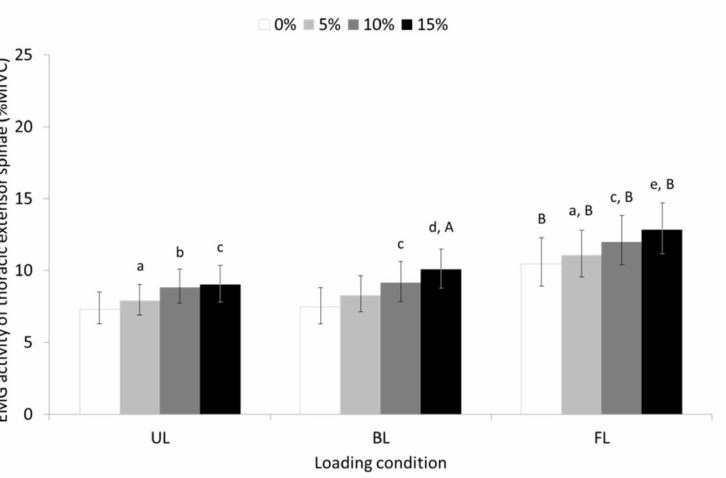
Figure 3. Geometric means and 95% confidence intervals (error bars) for the EMG activity of the thoracic erector spinae during unloaded (UL), back-loaded (BL), and front-loaded (FL) walking at 0 (level), 5, 10, and 15% uphill slope. a significant different (SD) compared to 0% slope ( p ≤ 0.01); b SD compared to 0% ( p ≤ 0.001) and 5% slope ( p ≤ 0.05) c SD compared to 0 and 5% slope ( p ≤ 0.001); d SD compared to 0, and 5% slope ( p ≤ 0.001) as well as 10% slope ( p ≤ 0.05); e SD compared to 0, and 5% slope ( p ≤ 0.001) as well as 10% slope ( p ≤ 0.01); A SD compared to UL condition ( p ≤ 0.05); B SD compared to UL and BL condition ( p ≤